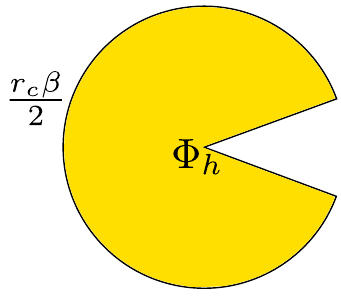
Figure 6 . Saddle point for the E -basis Hartle-Hawking wave